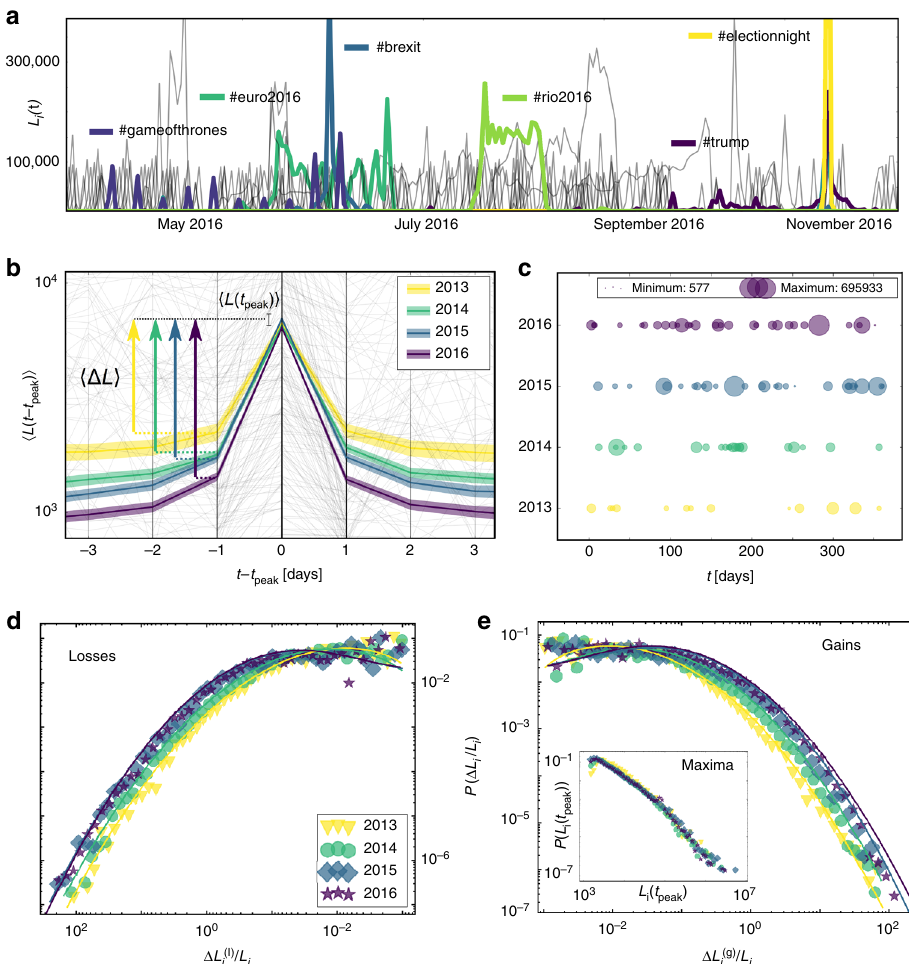
Fig. 1 Measuring the speed of hashtag dynamics: a Daily usage L i ( t ) of the top 50 hashtags i on Twitter in 2016, with exemplary highlighted major events. b Average trajectories 〈 L ( t − t peak ) 〉 leading to a local maximum L i ( t peak ) in all top hashtags from 2013 to 2016. The shaded area shows the 95% con fi dence intervals (CI). In the background a 1% random sample of trajectories is shown in grey. c Temporal density of extreme events (local maxima with a lower threshold for the slopes, for details see Methods section), scattered over 365 days. d Distribution of daily relative losses P ð Δ L ð l Þ i = L i Þ and e daily relative gains P ð Δ L ð g Þ i = L i Þ . The solid lines show fi tted log-normal distributions P ð x Þ ¼ 1 = ð x σ The corresponding distributions of the local maxima of each hashtag trajectory P ( L i ( t peak )) (distributions truncated at 10 3 ). Source data are provided as a Source Data fi le and in an online repository (see data availability